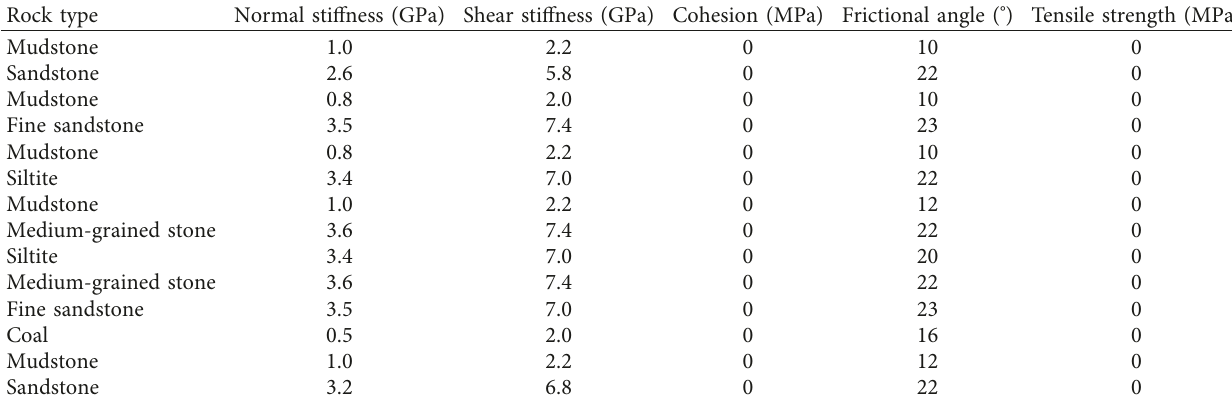
Table 5: Mechanical parameters of contact surface of strata in the